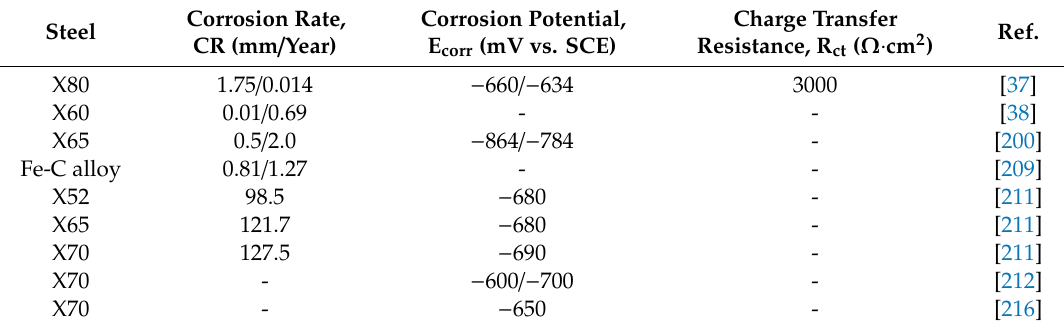
Table 10. Reviewed electrochemical properties for internal corrosion